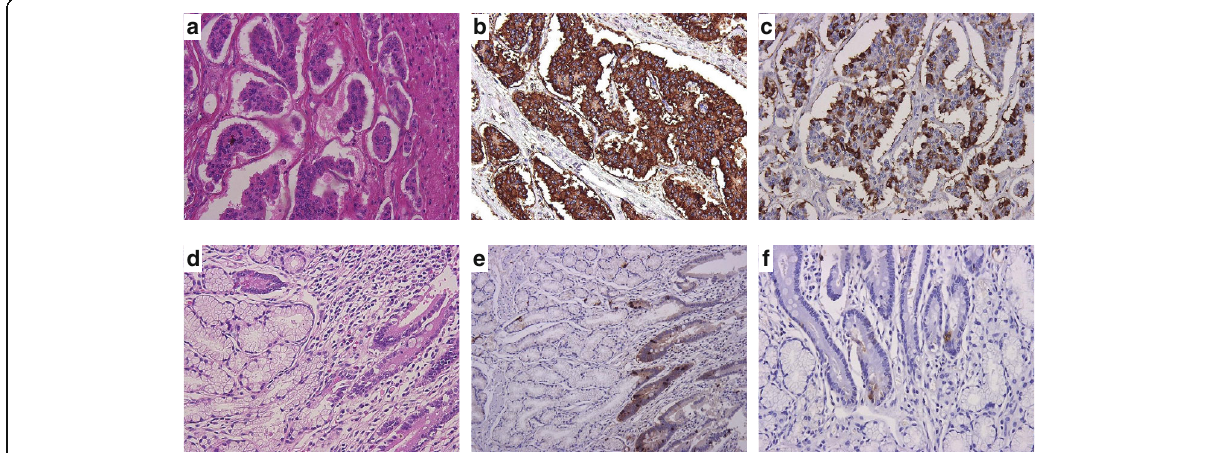
Fig. 4 Histopathological examinations. a Hematoxylin and eosin staining of the liver mass showing a funicular, solid, and tubular increase of small cube-shaped, atypical cells (×200 magnification). b Immunostaining for chromogranin A of the liver mass was positive (×200 magnification). c Immunostaining for gastrin in the liver mass was positive (×200 magnification). d Hematoxylin and eosin staining of the duodenum showing hyperplasia of the Brunner ’ s glands (×200 magnification). e Immunostaining for chromogranin A in the duodenum was negative (×100 magnification). f Immunostaining for gastrin in the duodenum showing a small gathering of gastrin-positive cells (×200